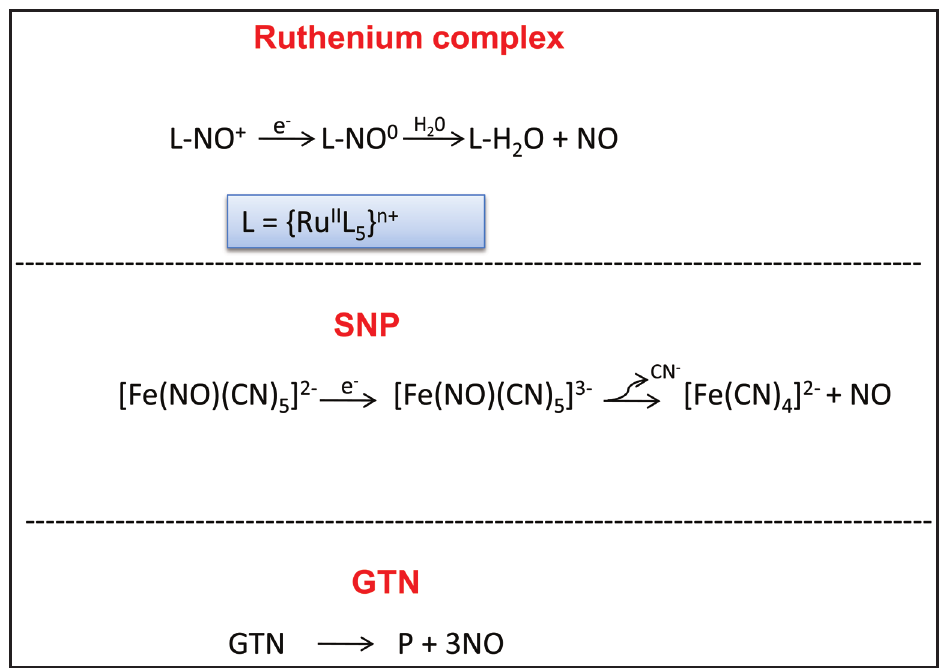
Figure 2. Nitric oxide (NO) release from ruthenium complexes, inorganic nitrate (sodium nitroprusside, SNP), and organic nitrate glyceryl trinitrate, GTN). L = ligand; P =